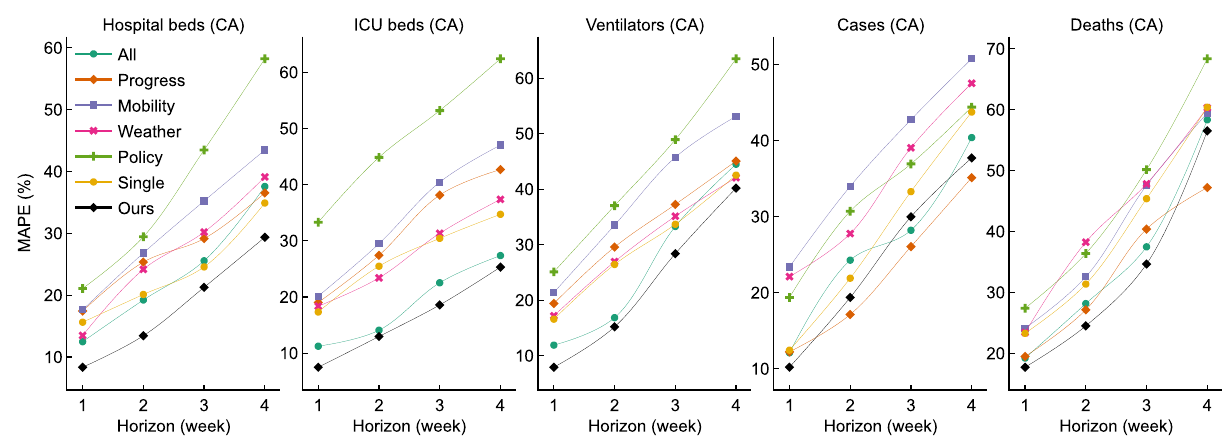
Figure 5. Comparison of the performance (in terms of MAPE) of TCN models using the various factors as